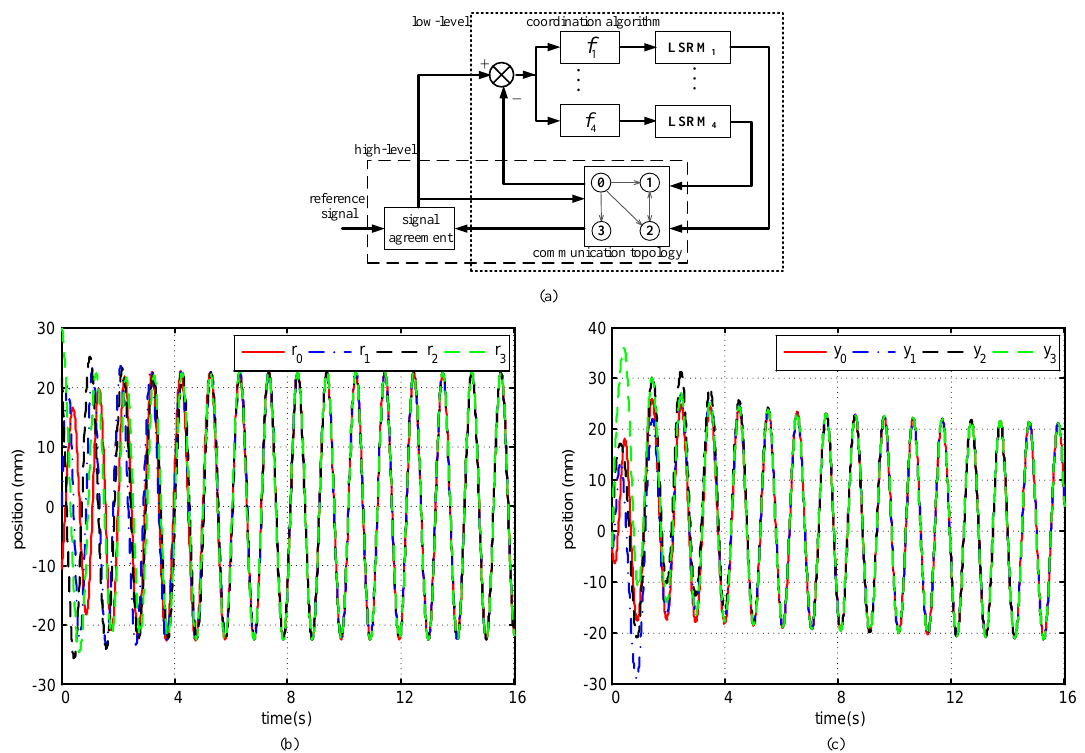
Figure 5. ( a ) control block diagram of the LSRMs network, ( b ) simulation results of reference, and ( c ) actual